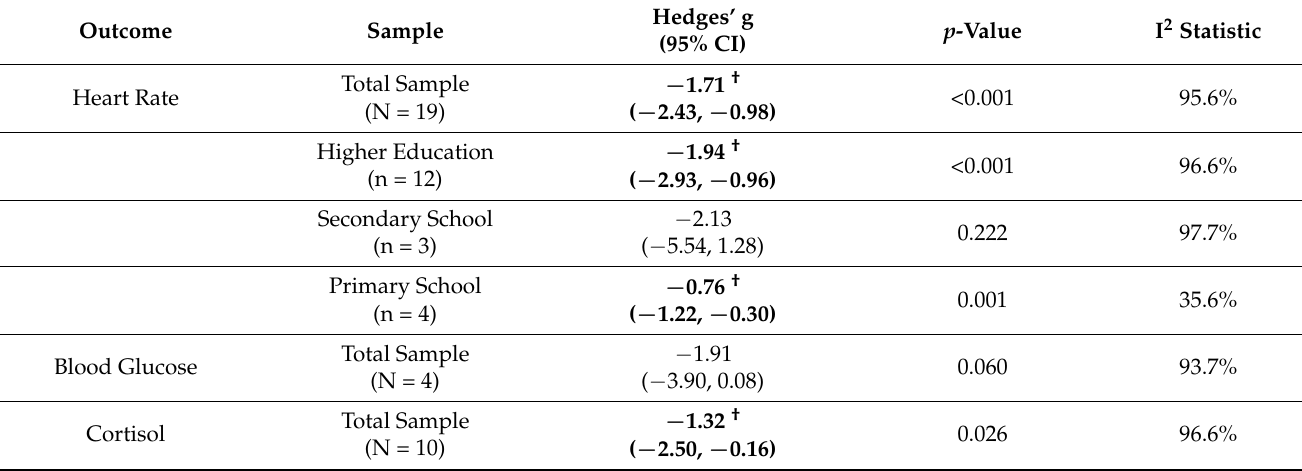
Table 2. Random-effects meta-analysis effect sizes across outcomes and education